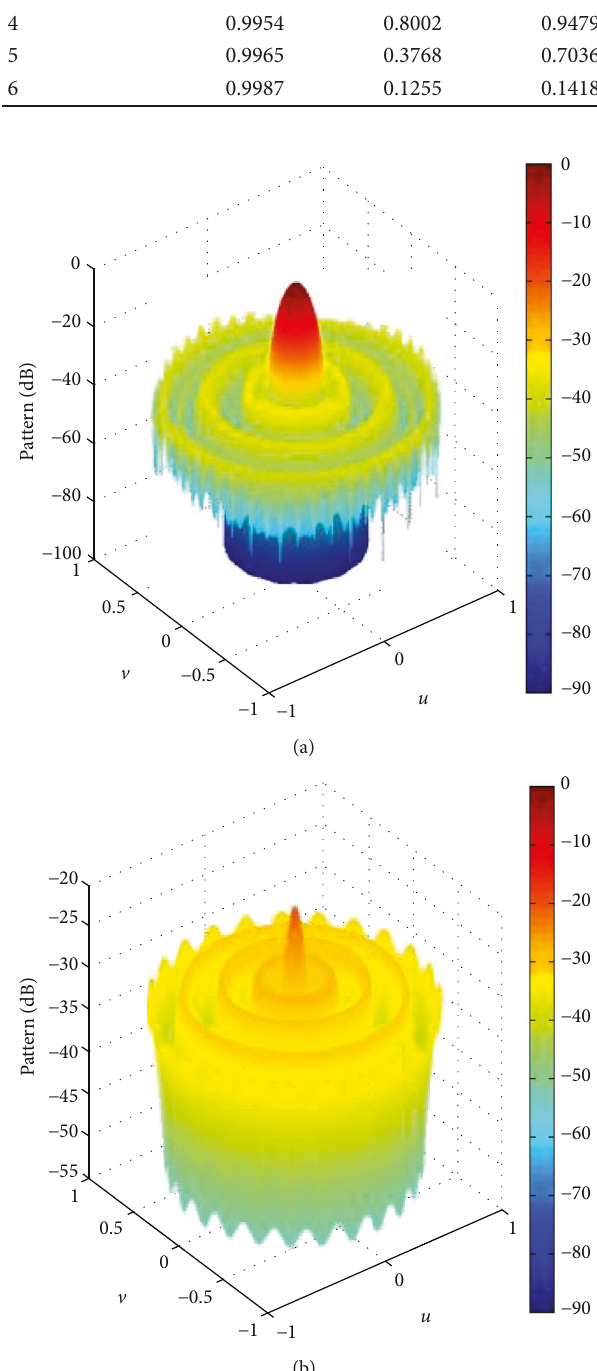
Figure 8: Radiation patterns for individual C 3 : (a) at the center frequency ( s =0) and (b) at the fi rst sideband ( s